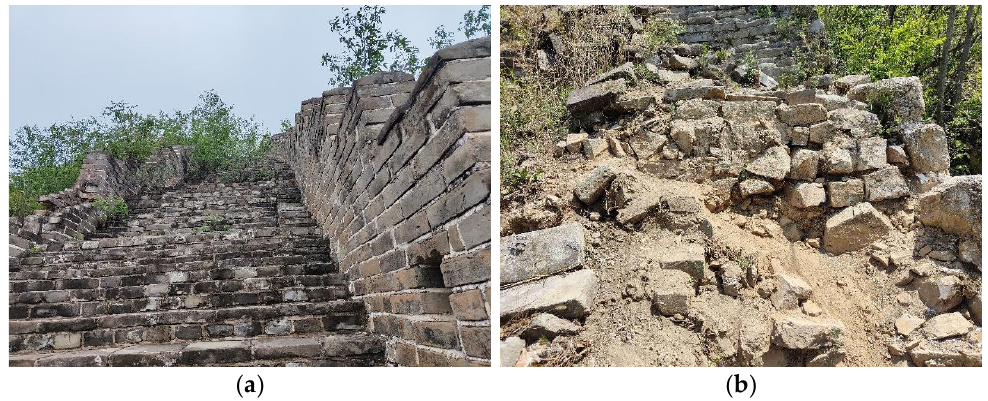
Figure 7. Slope section of the great wall: ( a ) Normal; ( b ) Collapsed steps.